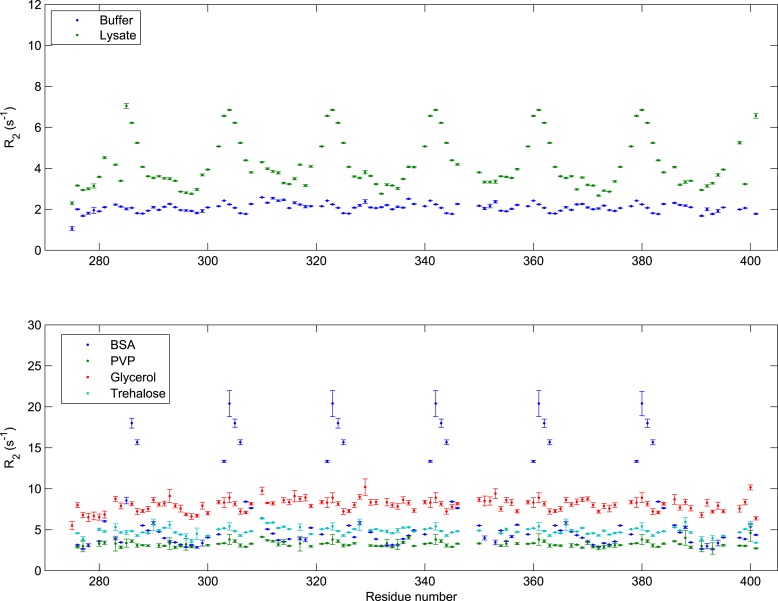
Transverse relaxation of FSFG-K in multiple environments.All R2 data were collected at 25°C with 140 μM 15N-labeled FSFG-K in buffer A with the following delays: 0, 32.64, 65.28, 97.92, 130.56, 163.20, 195.84, 228.48, 261.12, and 326.40 ms. The concentrations of the different additives are as follows: E. coli lysate (Wang et al., 2011; Latham and Kay, 2014) 230 mg/ml; BSA 205 mg/ml Glycerol (Li et al., 2009; Wang et al., 2011) 60% wt/wt; PVP-10 (Li et al., 2008, 2009) 111 mg/ml; Trehalose (Lins et al., 2004; Chakrabortee et al., 2010) 154 mg/ml. Sequence-dependent fluctuation is seen only with lysate or with BSA, indicating non-specific rapid interactions, in contrast to changes of viscosity (Serber et al., 2005; Li et al., 2009; Wang et al., 2011), solvation (Lim and Deng, 2009; Xue and Skrynnikov, 2011; Kim et al., 2013), or packing (Li et al., 2009; Uversky, 2009; Milles et al., 2013). The E. coli lysate concentration is comparable to the estimated in vivo total concentration (Cayley et al., 1991). Interaction with BSA is consistent with previous observations (Parks et al., 1983; Higuchi et al., 1994; Clarkson et al., 1996; Fielding et al., 2005; Simard et al., 2006).